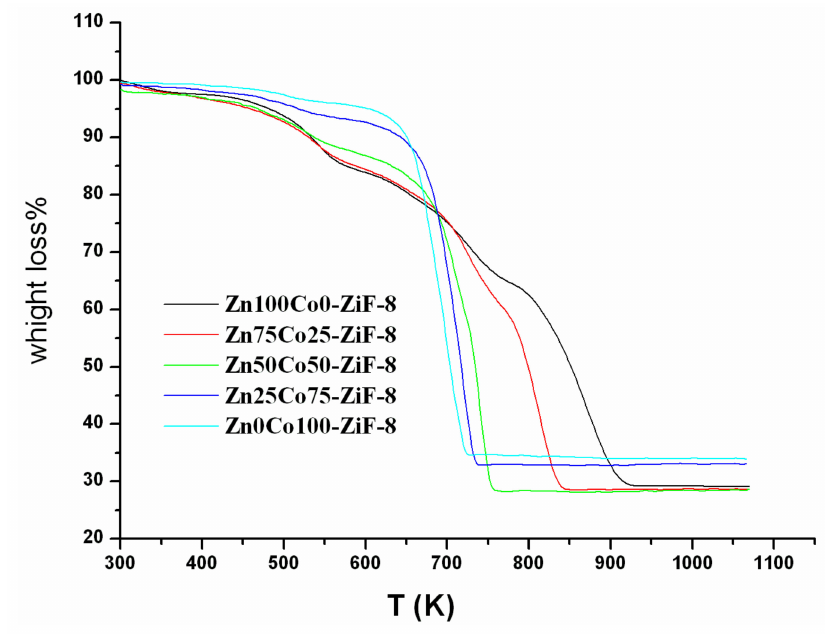
Figure 2. TGA curves for Zn x Co 1-x -ZIF-8 at heating rate 5